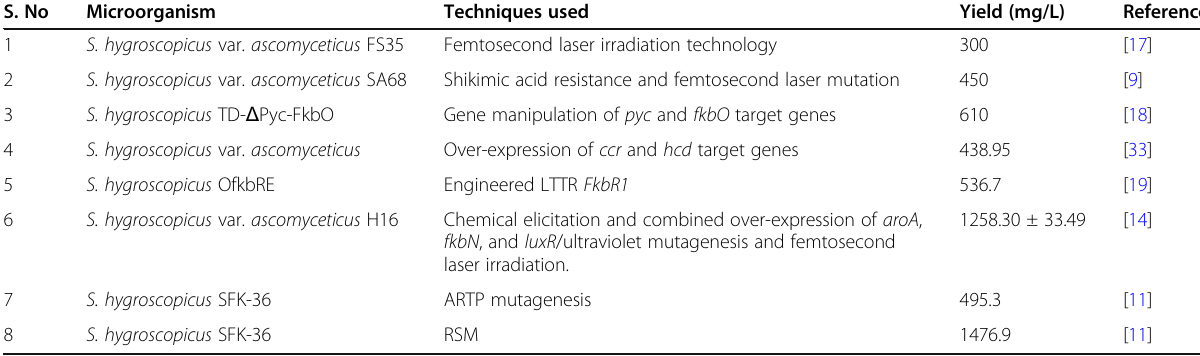
Table 2 Different strain improvement strategies employed in the production of ascomycin S.